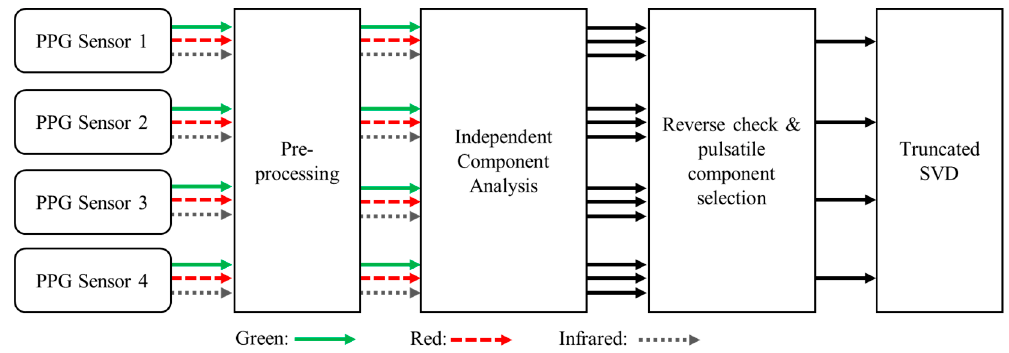
Figure 4. Block diagram of signal flows for each sensor and proposed algorithm.